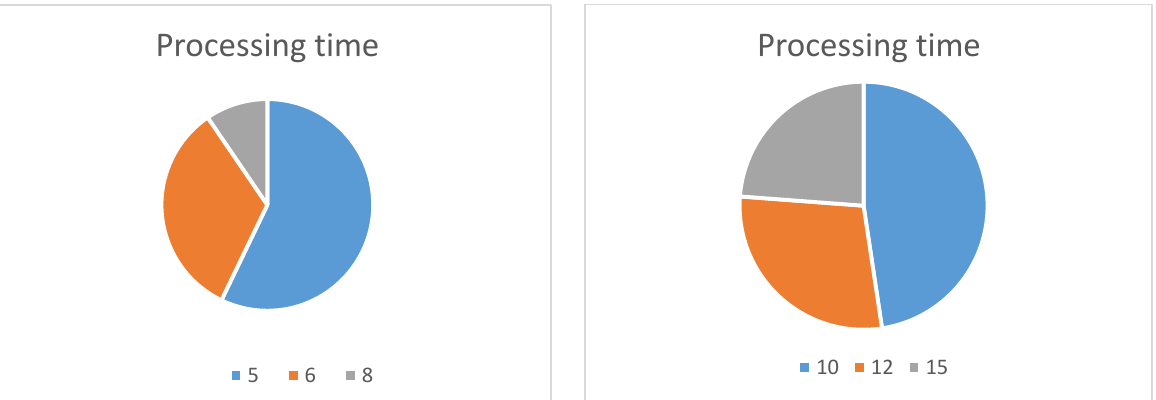
Figure 1. Estimated processing time in min for RBC. Figure 2. Estimated processing time in min for X-ray.